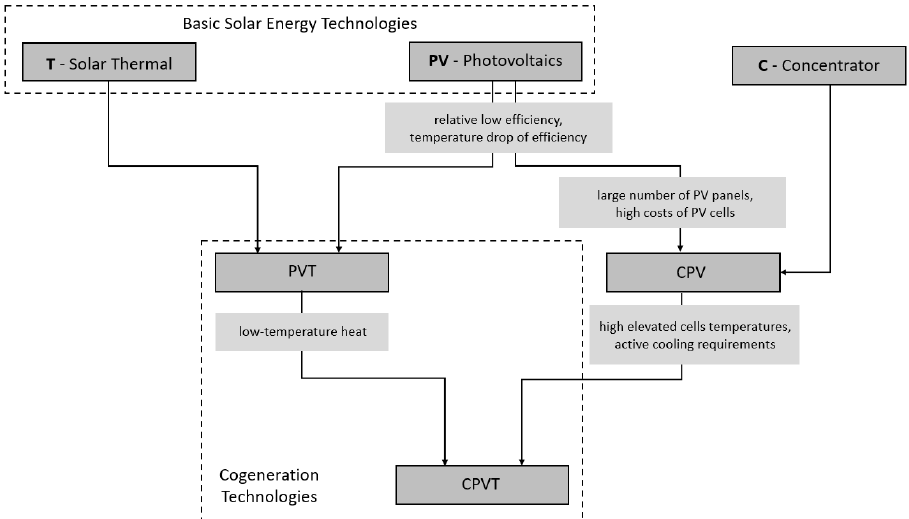
Figure 1. Evolution of basic solar energy technologies in CPVT system.